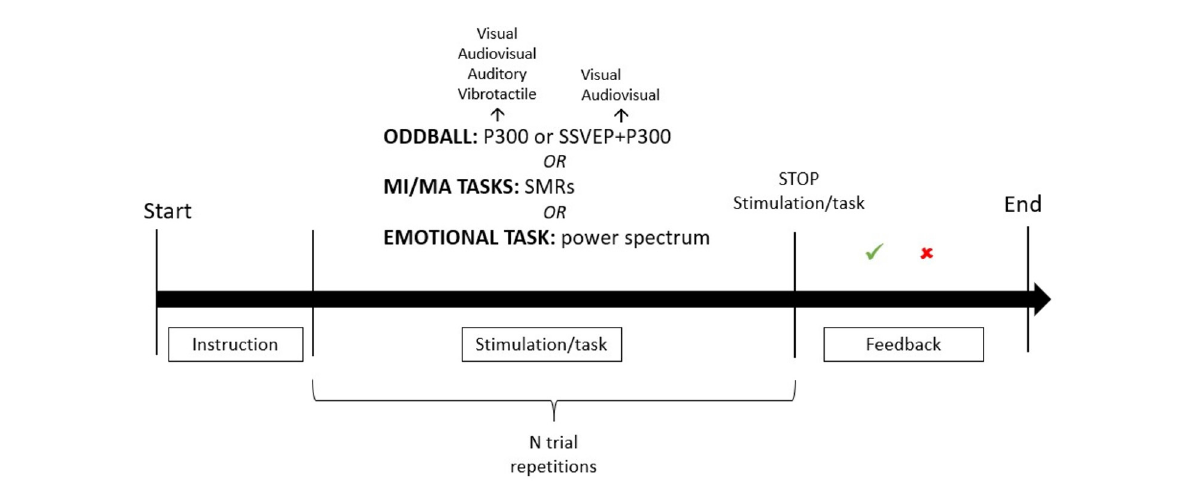
FIGURE2 General representation of a BCI paradigm. The figure illustrates a general pipeline of a BCI paradigm which could be adapted to each study included in the review. First, an instruction about the task is presented. After the instruction, the task starts and the stimulation is delivered. The possible tasks are: the oddball task, the motor imagery/motor action task or the emotional task. The oddball task is used both in the P300-based BCI and in the h-BCI; it could be presented in different sensory modalities (visual, audiovisual, vibrotactile and auditory for the P300-only BCI; visual or audiovisual for the h-BCI). A different number of trial repetitions can be delivered according to the specificity of each paradigm. After the stimuli presentation, the stimulation is interrupted, and the system delivers feedback about the appropriateness of the user’s response. A period of rest usually follows the feedback. See Supplementary Table 1 for further information about the timing of the stimulation, the number of trial necessary to each paradigm, the number of stimuli adopted in the interface/stimulation